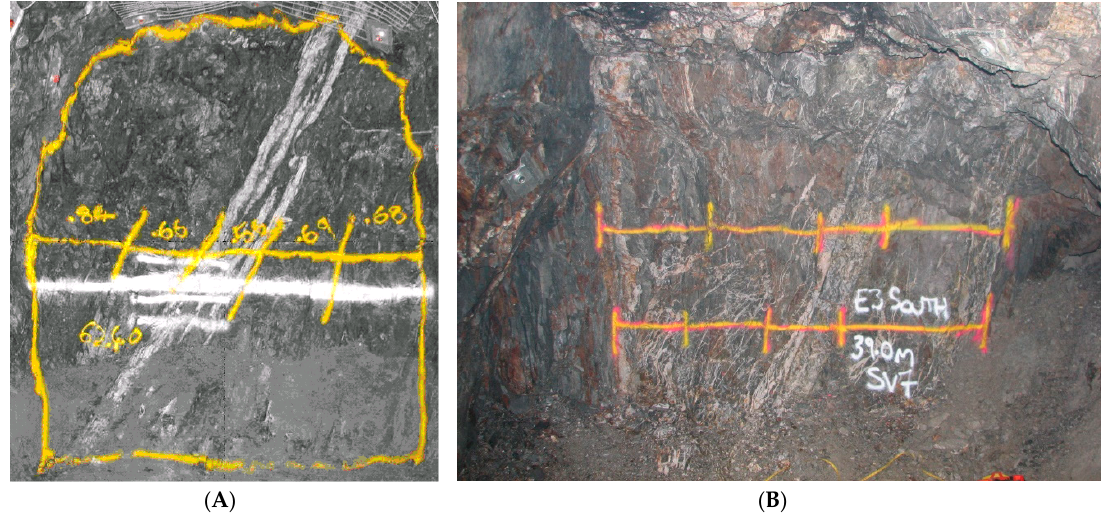
Figure 1. Face photographs showing sample lines based on geology: ( A ) A single chip sample line divided into a central vein sample with associated hanging and footwall samples; ( B ) Dual face chip sample lines across a sheeted vein zone.